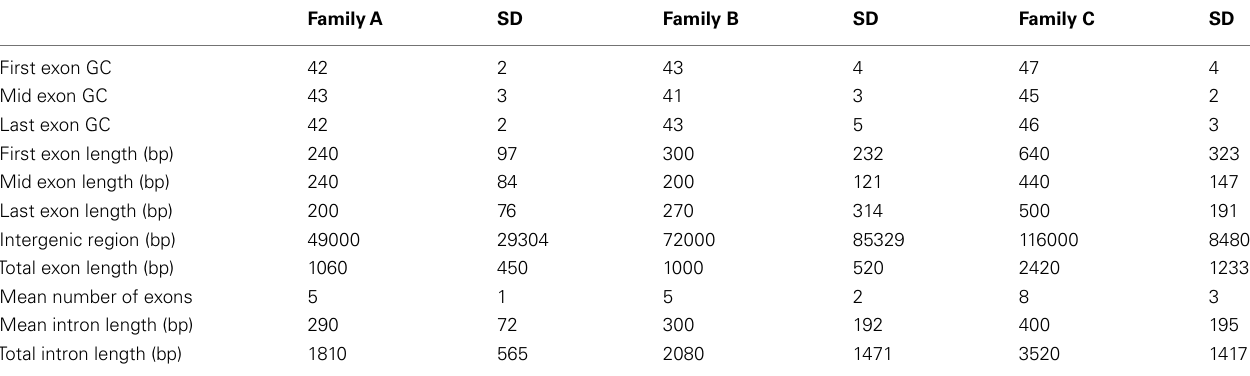
Table 4 |The physical parameters of the genes in soybean LHGR FamilyA, Family B, and Family C. FamilyA SD Family B